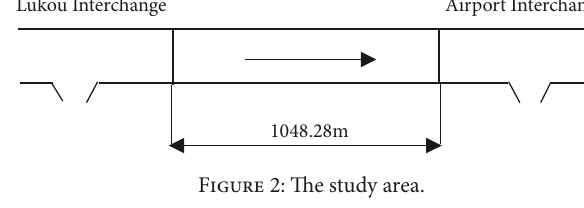
Figure 2: The study